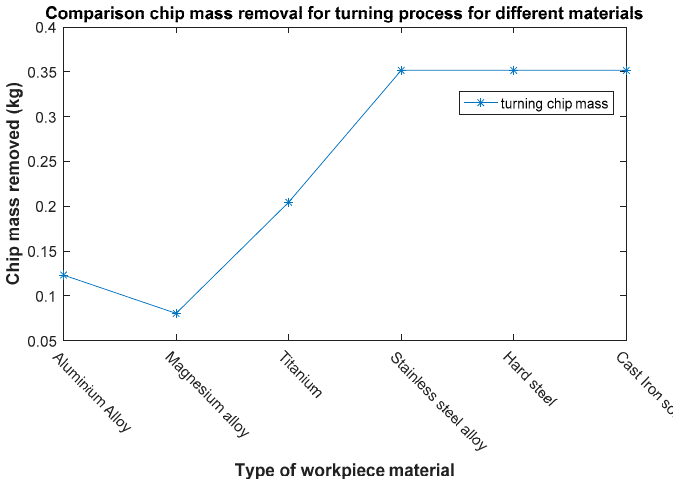
Figure 13. Comparison of chip mass removal for turning processes for different materials.